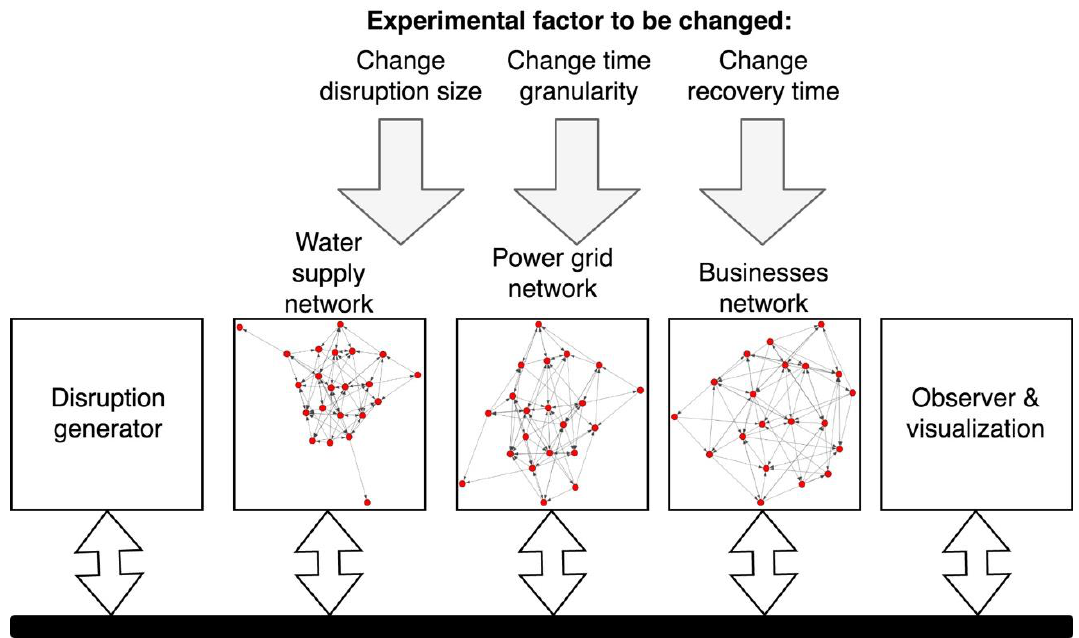
Figure 3. Experimental model system setup for 3 networks and disruption generator.